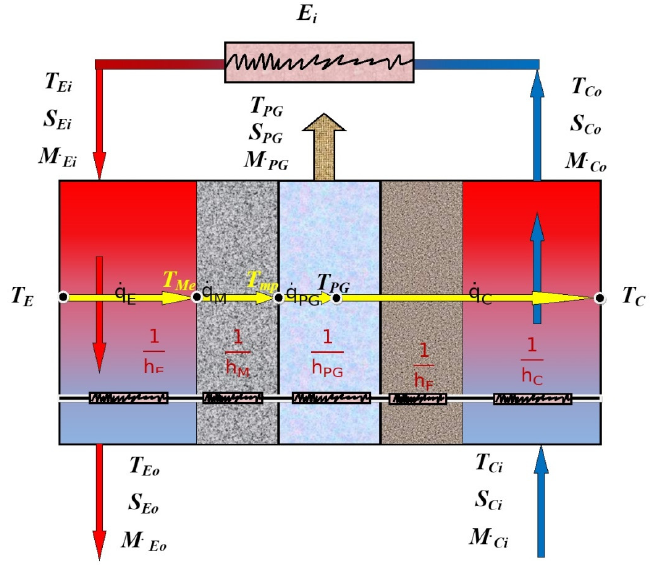
Figure 5. Schematic of a membrane distillation desalination system.